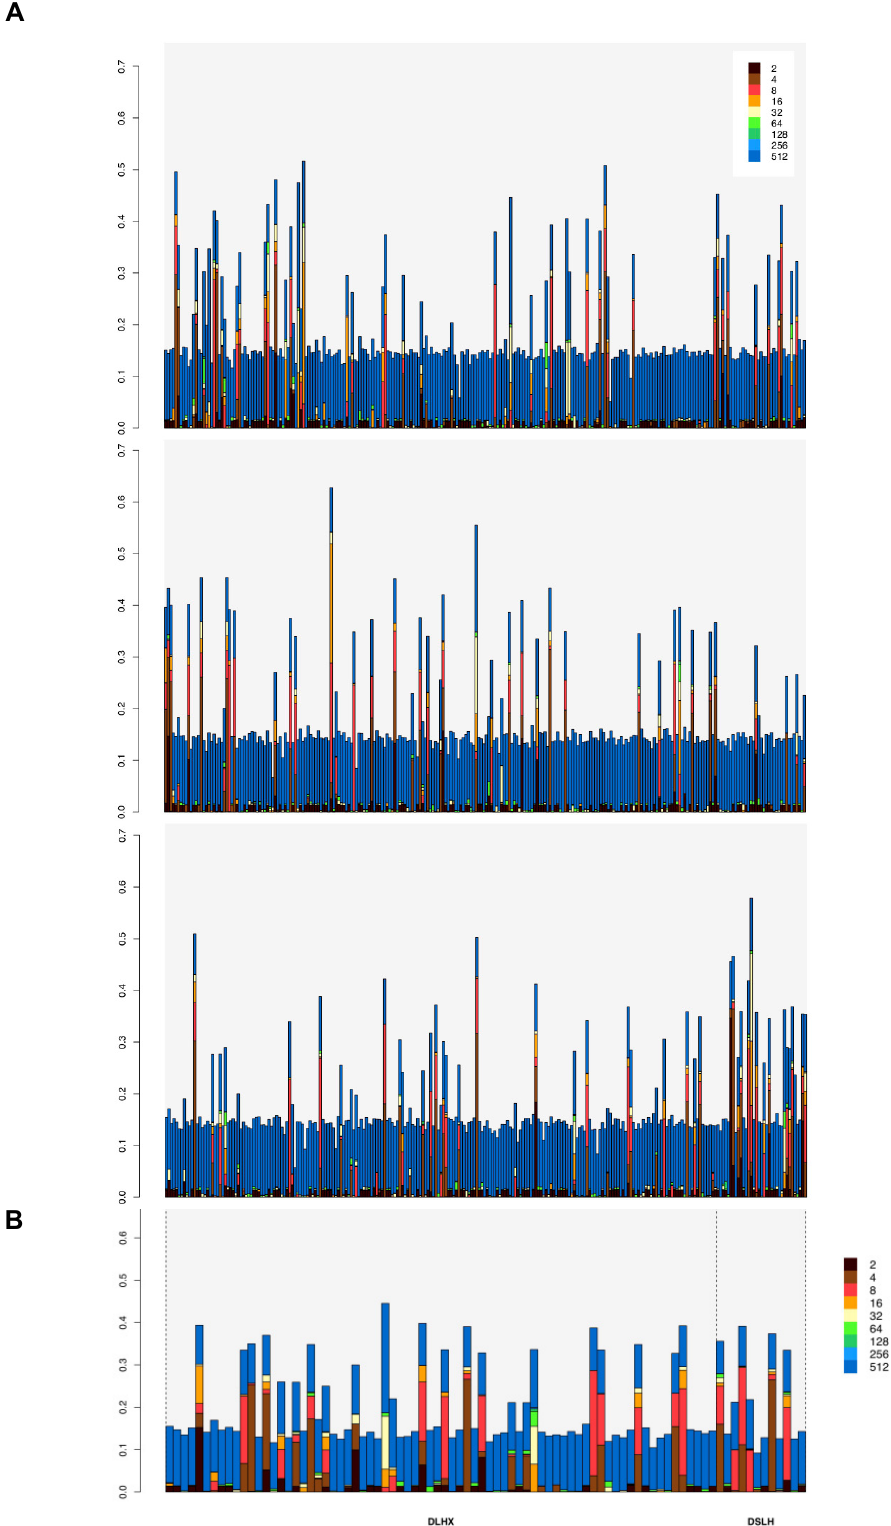
Figure A7. Genomic content of homozygosity by descent (HBD) segments domestic cats. HBD segments were classified by segments’ ages with respect to inferred generation time. The colour legend indicates the HBD class, defined by R k , to reflect the inheritance of HBD from common ancestors across many generations. ( A ) Genomic content of HBD segments for DSH cats ( n = 754) and ( B ) of the DLH cats ( n = 74) cats and DSLH cats ( n = 12).